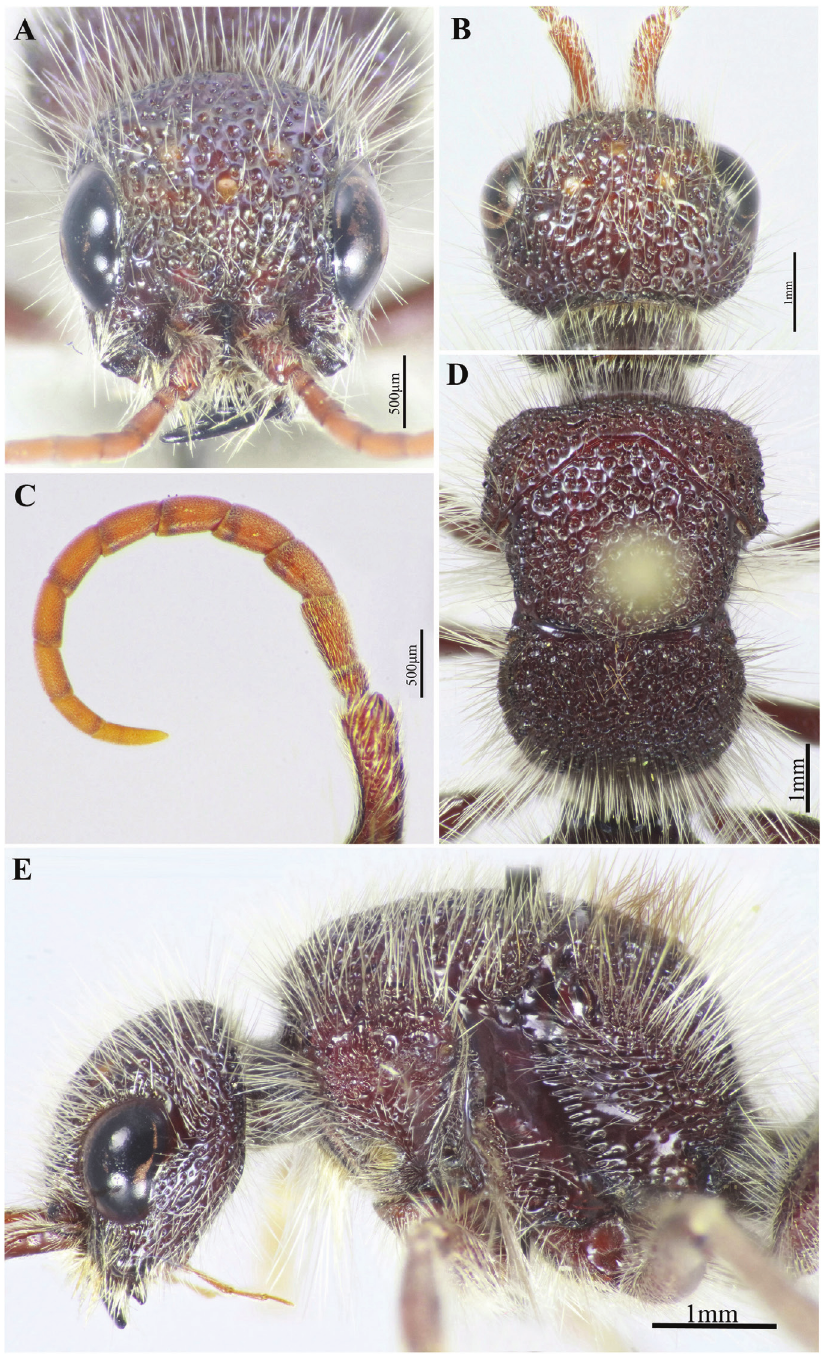
Figure 27. Pseudophotopsis maura Bischoff (Female) A head, frontal view B head and antennal scape, dorsal view C antenna D mesosoma, dorsal view E head and mesosoma, lateral